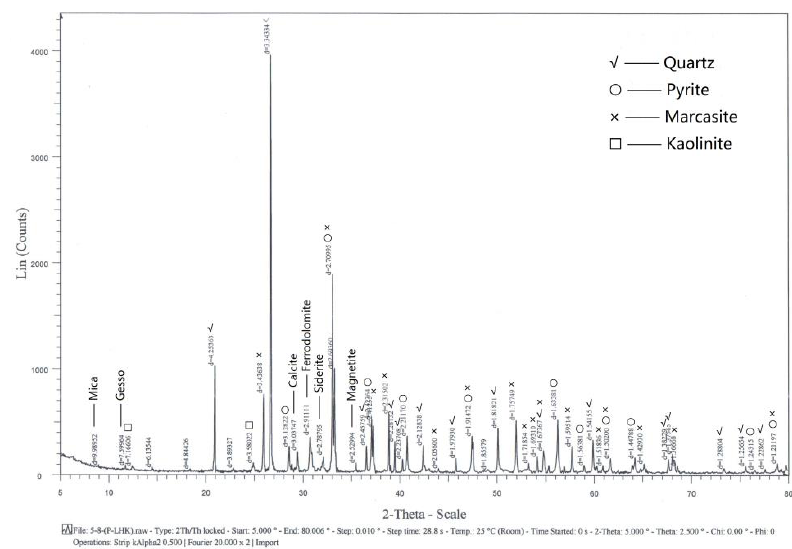
Figure 1. XRD patterns of the ore samples.